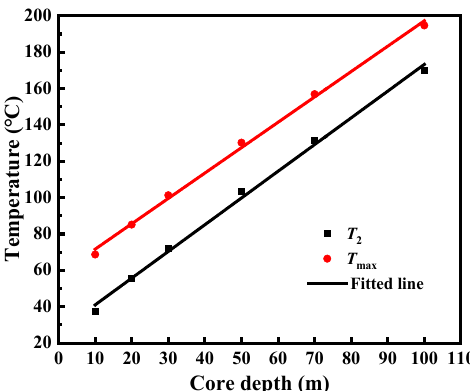
Figure 15. Temperature of measuring point at different core depths in JLS. T 2 is the temperature of measuring point at the end of the second stage; T max is the maximum temperature of measuring point during coring.